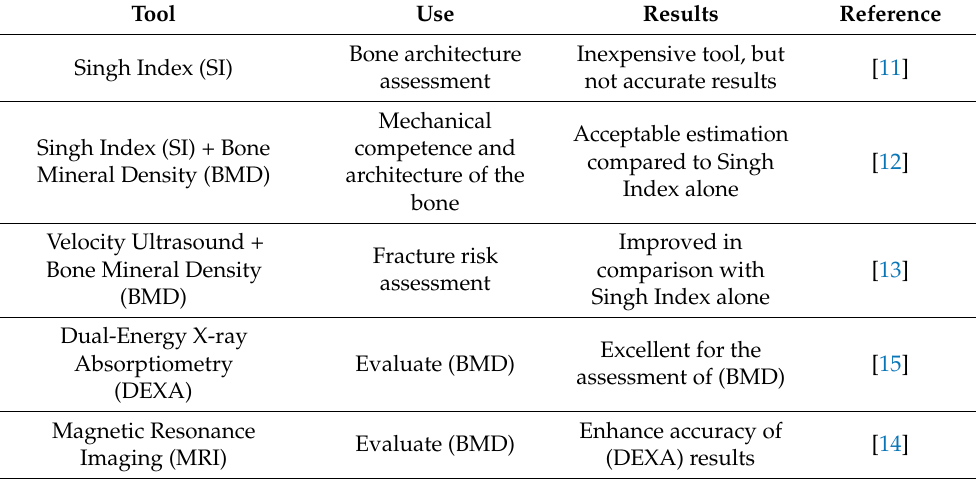
Table 1. Diagnostic tools used for bone assessment and their efficiency as